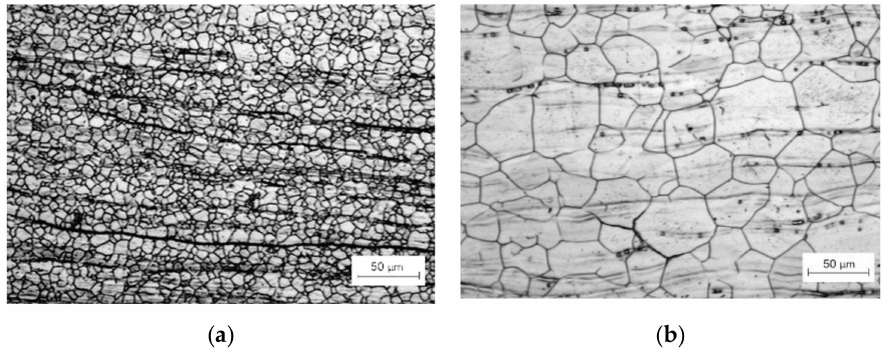
Figure 5. Austenitic grain size of two specimens after austenitization at 980 ◦ C ( a ) and 1200 ◦ C ( b